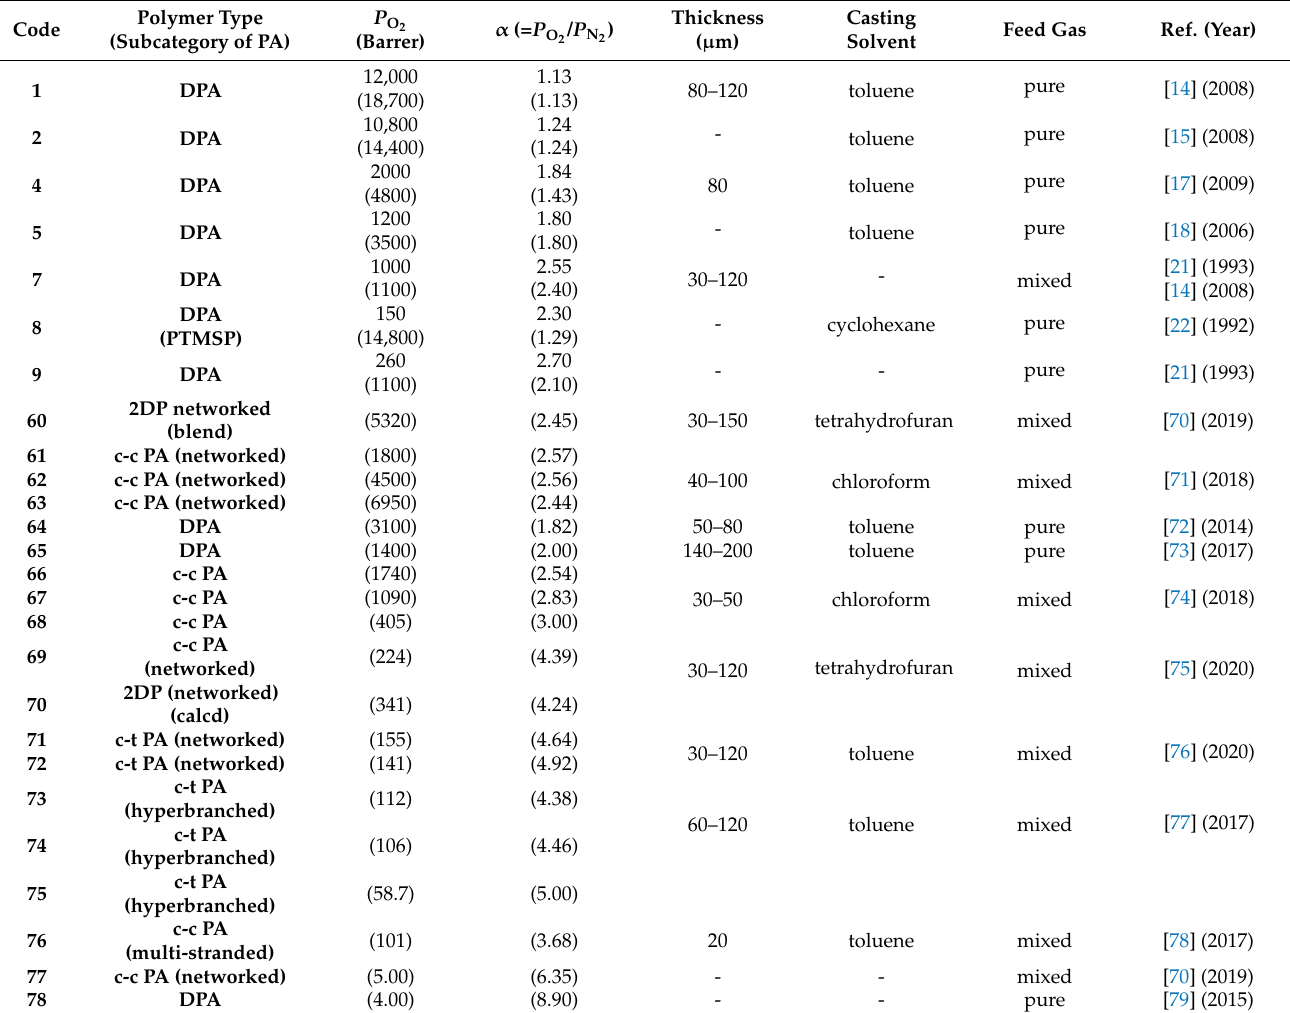
Table 5. Categorization and detailed data for the membrane polymers in Figure 7 (PAs in 2020). Polymer Type Code (Subcategory of